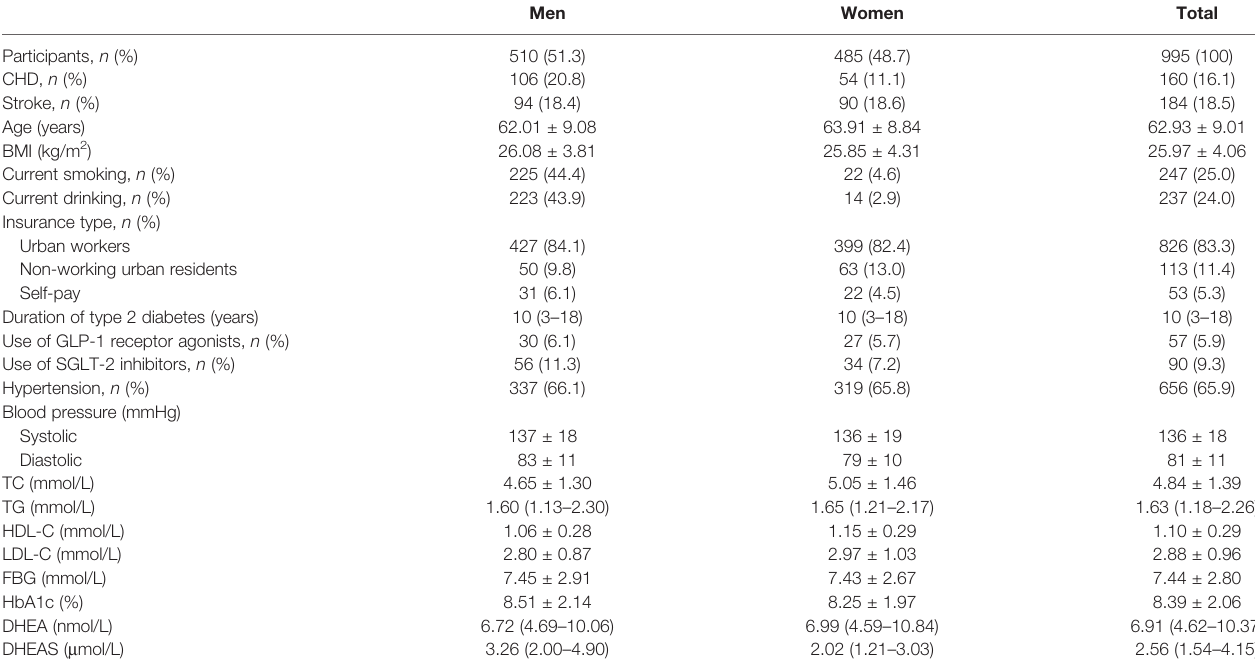
TABLE 1 | Characteristics of patients with type 2 diabetes